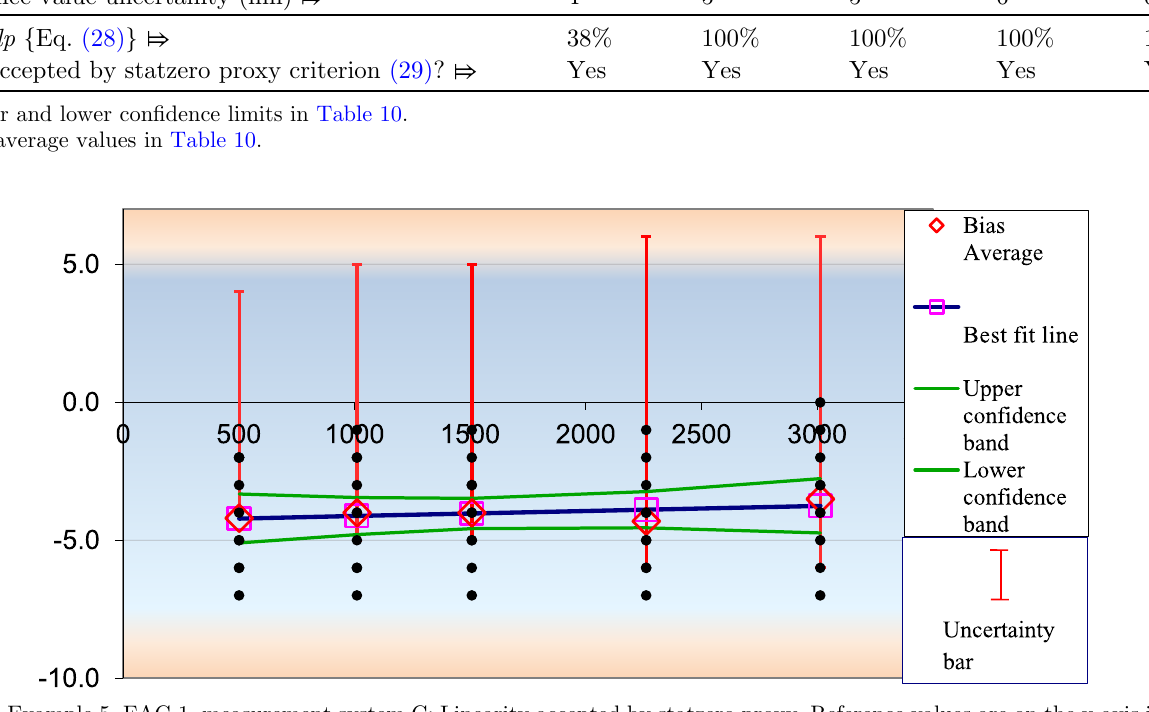
Fig. 5. Example 5, FAC-1, measurement system C: Linearity accepted by statzero proxy. Reference values are on the x-axis in nm units [xo = R con (j)]. Bias data are on the y-axis in nm units (solid